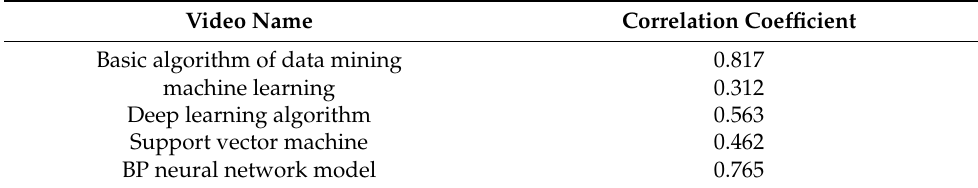
Table 12. Correlation coefficient for videos with no nil.